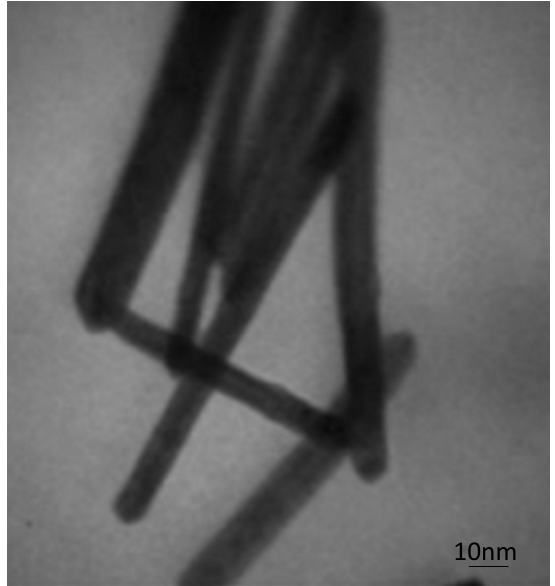
Figure 2. TEM image of dysprosium